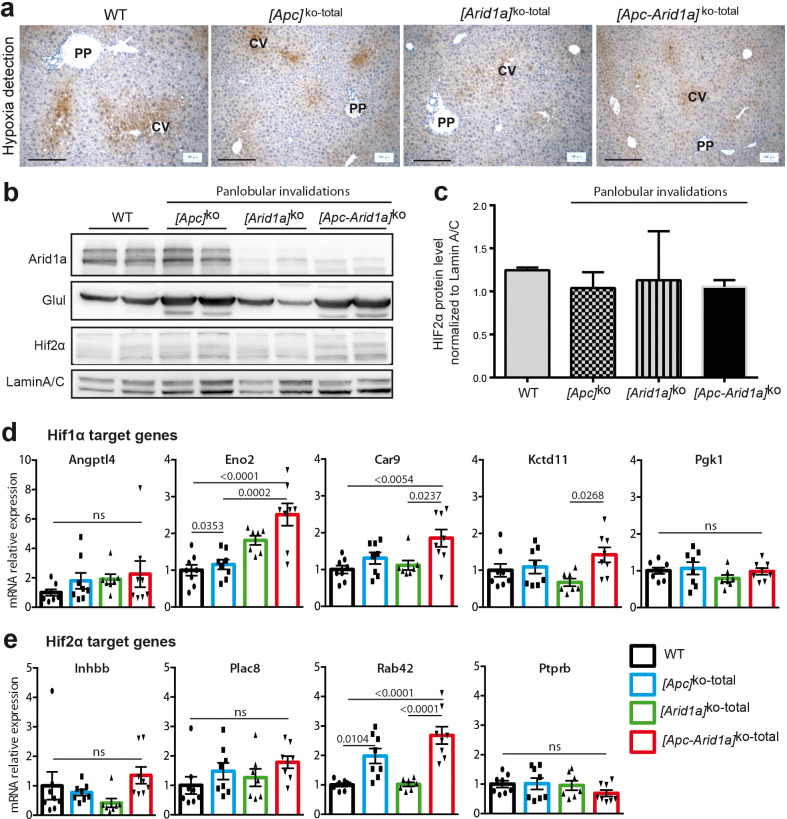
Lack of hypoxia and HIF signaling in [Apc-Arid1a]ko-TOTAL livers.(a) Immunodetection of hepatic hypoxia seven days after Apc and/or Arid1a loss in all hepatocytes in mouse liver. For hypoxia detection in tissues, mice were injected with Hypoxyprobe (NPI Inc) solution via intraperitoneal injection (60 mg/100 g body weight), and livers harvested 1 hr after. Paraffin sections were processed according to the manufacturer’s instructions (Hypoxyprobe-1 Kit). Note the physiological staining surrounding the centrilobular vein (cv) in all conditions. No pathological and extended hypoxia was detected. Scale bars = 200 μm. (b,c) Western blots of Arid1a, Glul, Hif2α, and actin (b), and Hif2α detection quantification (n = 2 for each genotype) (c) showing no Hif2α stabilization in either condition. (d) RT-qPCR analysis of Hif1α and Hif2α target gene expression in livers of 2-month-old mice, 1 week after panlobular Apc and Arid1a invalidation. WT (n = 8), [Apc]ko-TOTAL (n = 8), [Arid1a]ko-TOTAL (n = 7), and [Apc-Arid1a]ko-TOTAL (n = 8) mice. One-way ANOVA tests were done. ns = non significant.Figure 7—figure supplement 1—source data 1.Quantification of western blots (Figure 7—figure supplements 1c) and mRNA expression (Figure 7—figure supplements 1d-e).